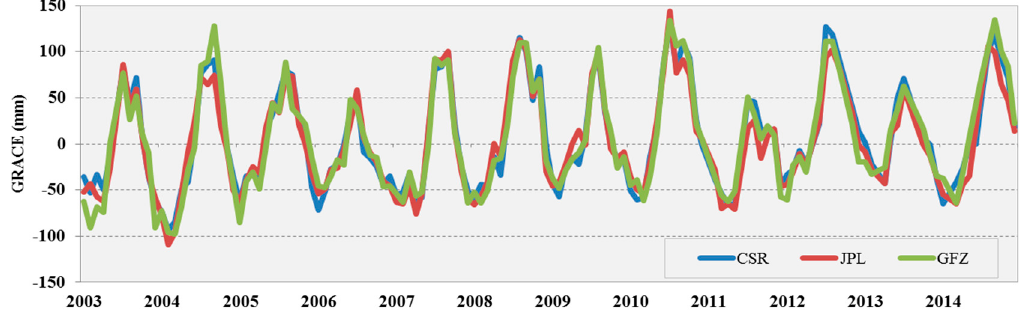
Figure 2. Terrestrial Water Storage Anomaly time series for three gridded data products (Texas Center for Space Research, CSR; the Jet Propulsion Laboratory, JPL; and the German Research Centre for Geosciences, GFZ) in the Yangtze River Basin.